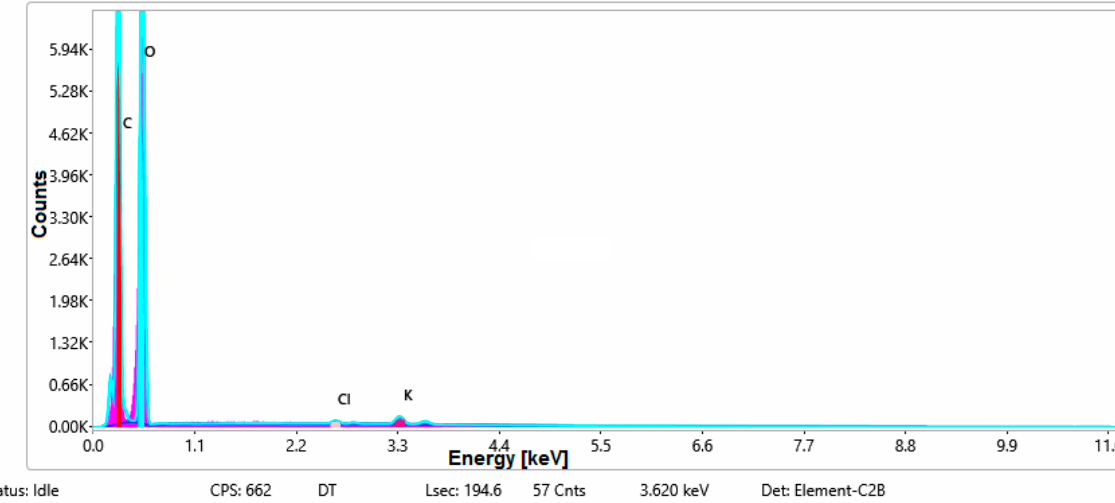
Figure 16. ESD spectra for sample S3 treated in RF plasma O 2 , using RF 2 generator and power 100 W.